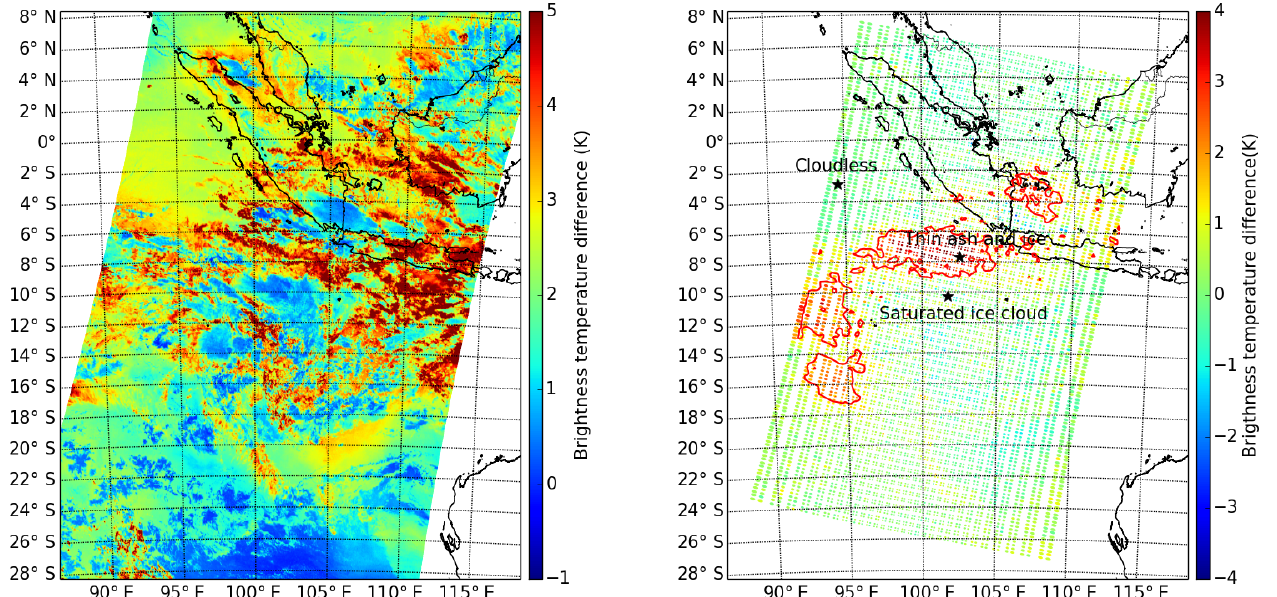
Figure 2. (Left panel) The brightness temperature difference between AVHRR/3 channels 4 and 5 (BTD A = BT 4 − BT 5 ). (Right panel) The 1231.5–1097.25cm − 1 brightness temperature difference from IASI/MetOp-A spectra. The contour line is at 1.5K. Data from 15 February 2014,